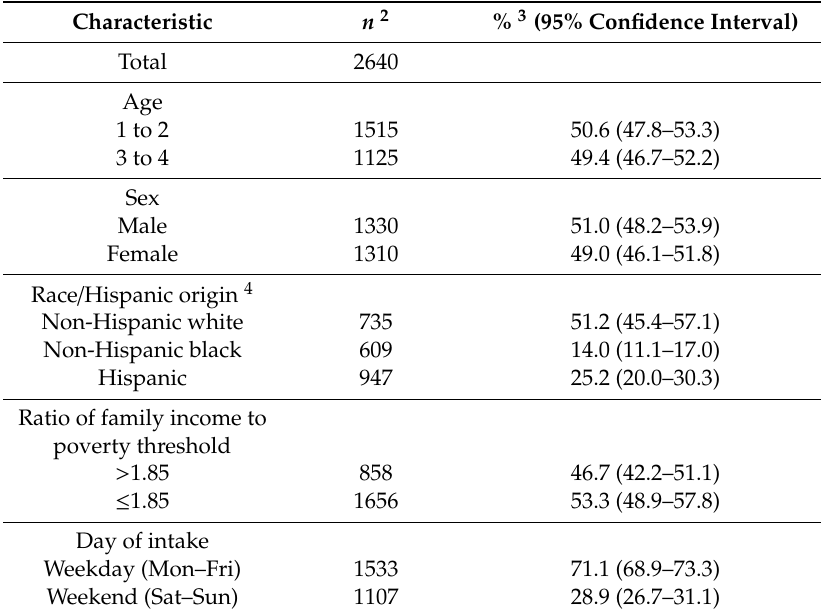
Table 1. Selected demographic characteristics of US children aged 1 to 4 years 1 , National Health and Nutrition Examination Surveys, 2009–2014 ( n =